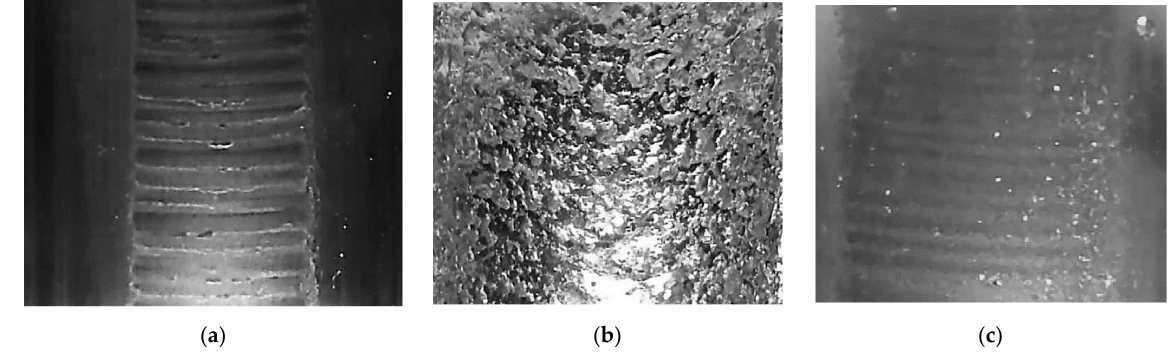
Figure 4. Faults caused by shaft currents: ( a ) fluting, ( b ) frosting, and ( c ) pitting.